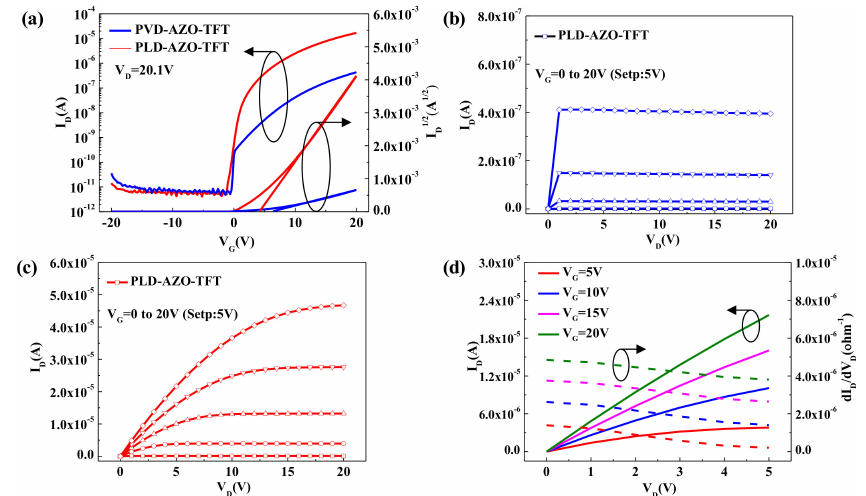
Figure 4. ( a ) Transfer characteristics of PVD-AZO-TFT and PLD-AZO-TFT; Output characteristics of ( b ) PVD-AZO-TFT and ( c ) PLD-AZO-TFT; ( d ) Output curve and its corresponding derivative curves in a linear region. Table 2. Summary of the electrical properties of the PVD-AZO-TFT and PLD-AZO-TFT.